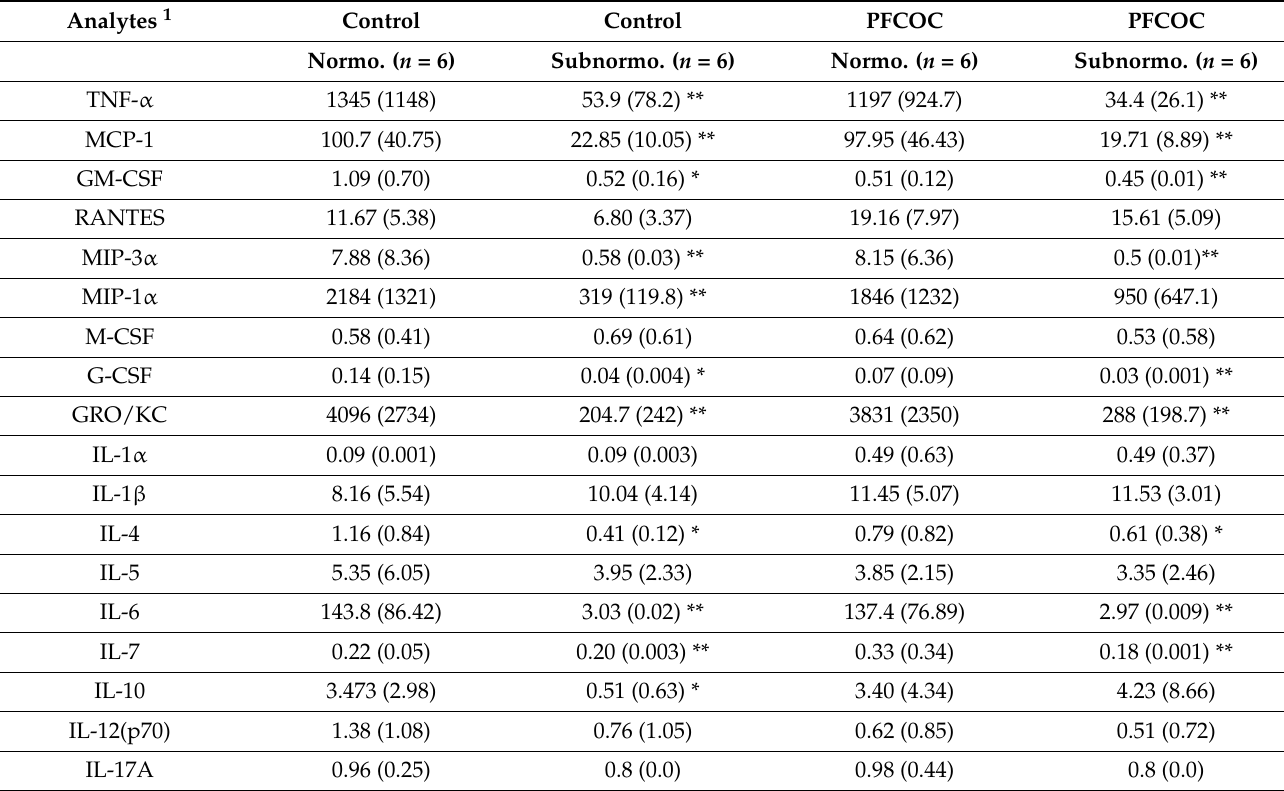
Table 1. Perfusate cytokines, chemokines and mediators of wound healing and tissue repair in the study